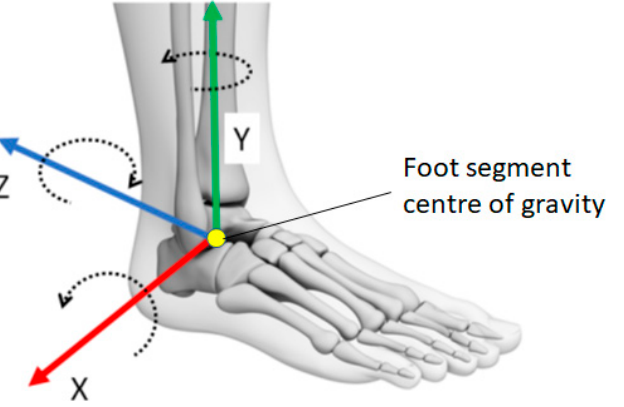
Figure 3. Definitions of foot kinematics data based on the segment coordination system. X, Y, Z in line with linear acceleration (+), arrows around the axes indicating positive (+) angular velocity direction.